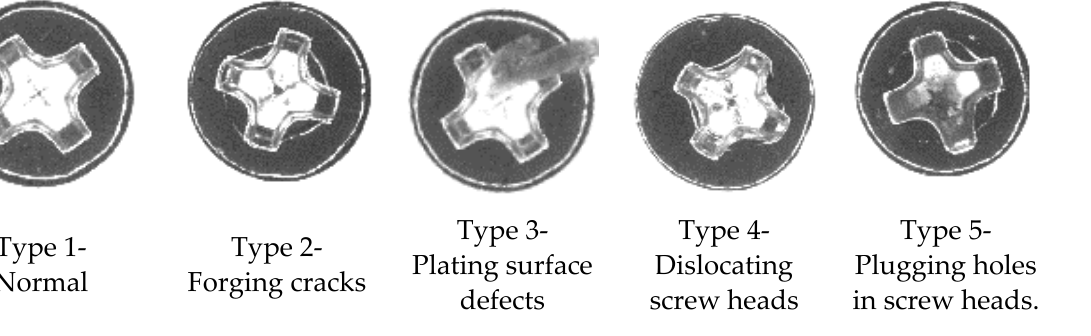
Table 4. List of datasets.